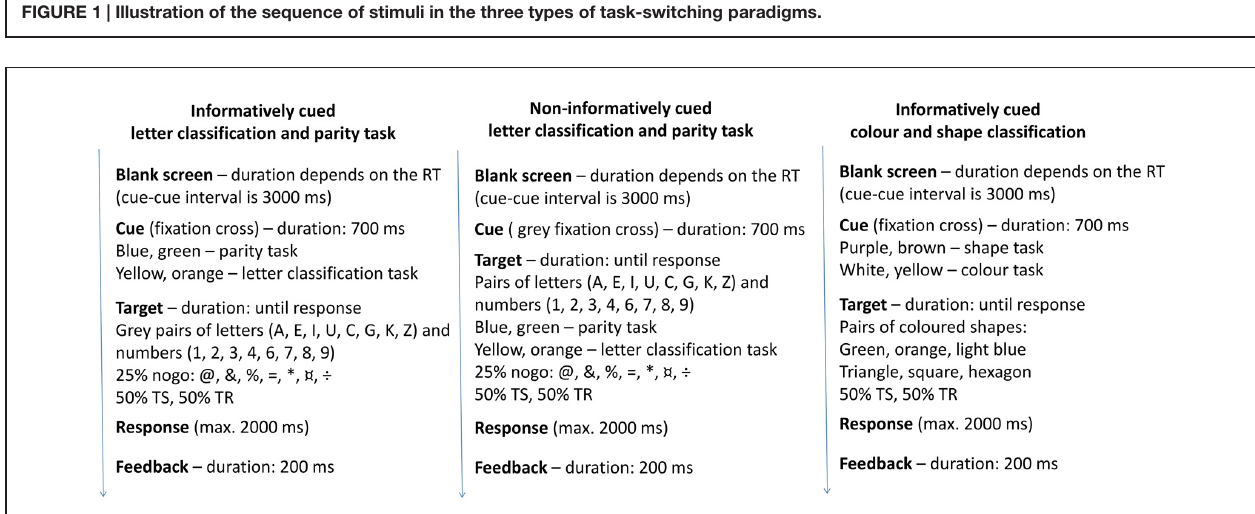
FIGURE 2 | The schemas of the three types of task switching paradigms with the details of stimulus presentation.